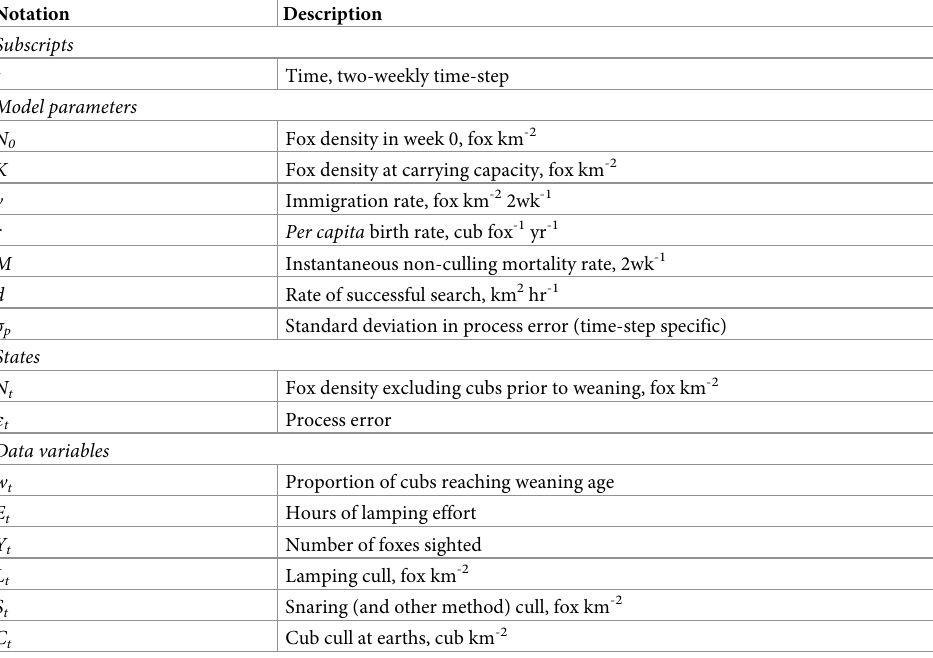
Table 1. Symbols and description of data variables and model